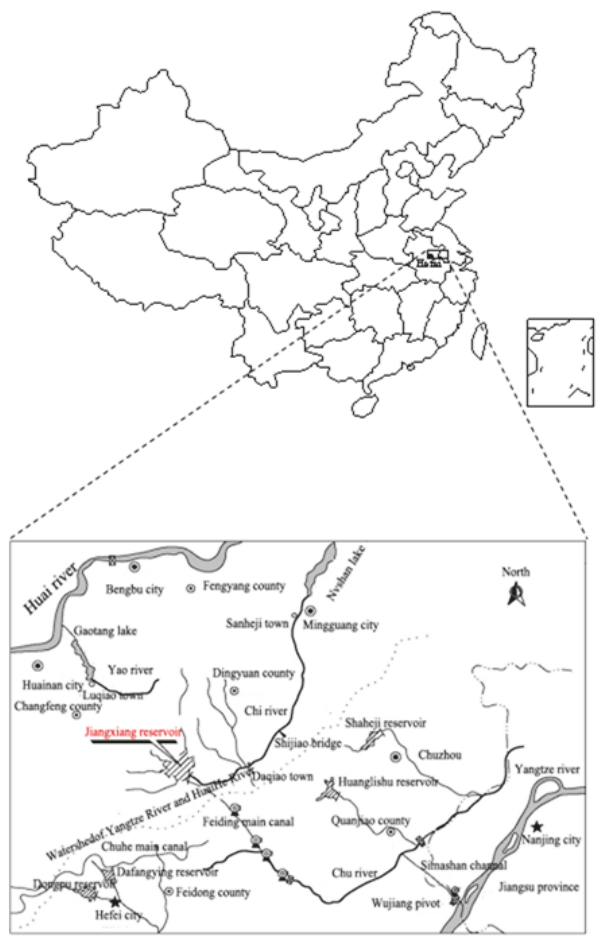
Figure 1: Location of Jiangxiang reservoir.